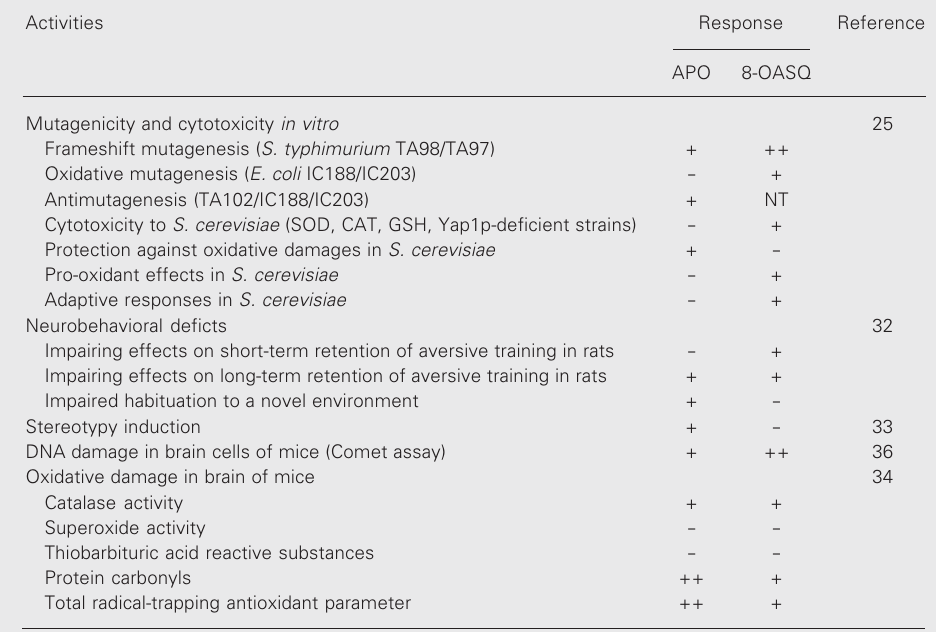
Table 3. Comparison of the cytotoxic, genotoxic and neurobiological effects of apomorphine (APO) and 8- oxo-apomorphine-semiquinone